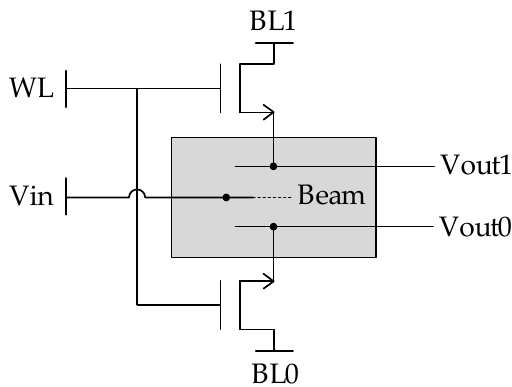
Figure 8. Schematic of a nanoelectromechanical (NEM) memory cell. NEM-Based CAM